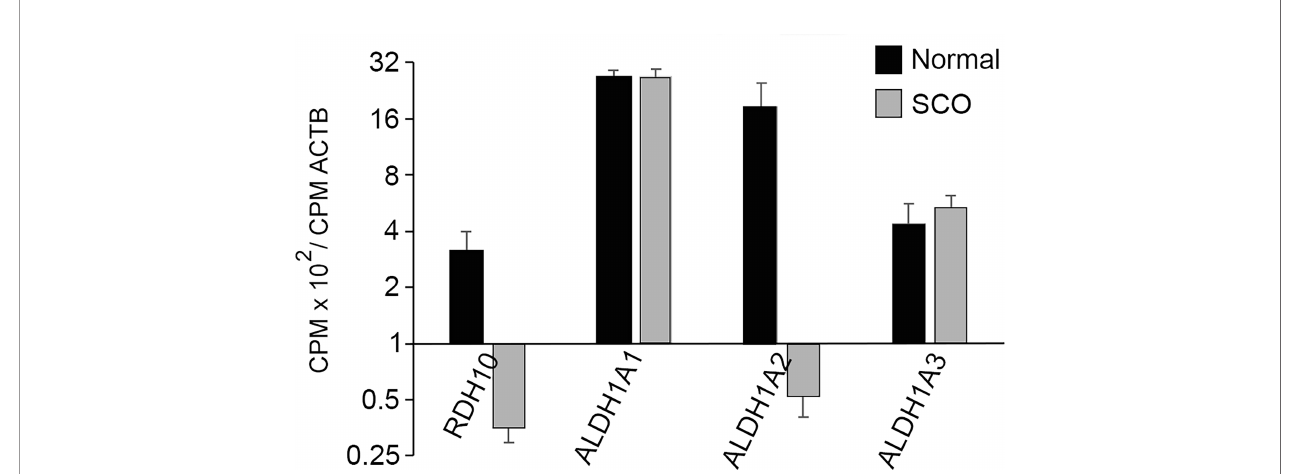
FIGURE 7 | The abundance in the transcriptomes of normal and SCO human testes of transcripts that encode the enzymes catalyzing the two-step conversion of retinol to retinoic acid. CPMs of each transcript in each of the transcriptomes of 4 normal and 7 SCO testes were normalized for CPM of b actin. Normalized data (mean + SEM) demonstrate that expressions of RDH10 and ALDH1A2 are substantially reduced in human SCO